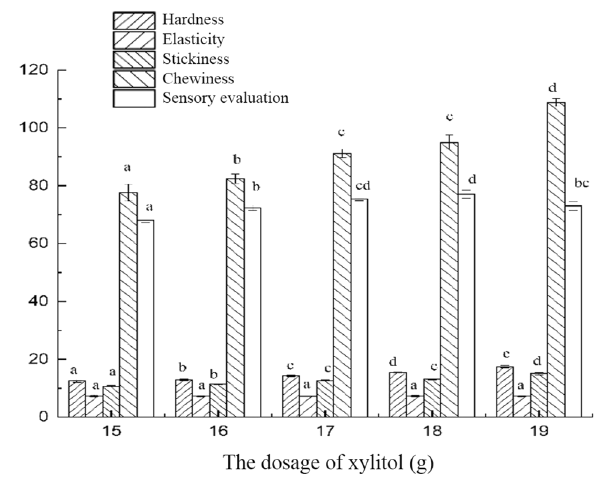
Fig. 3 Effect of xylitol addition on the quality of gel gummies